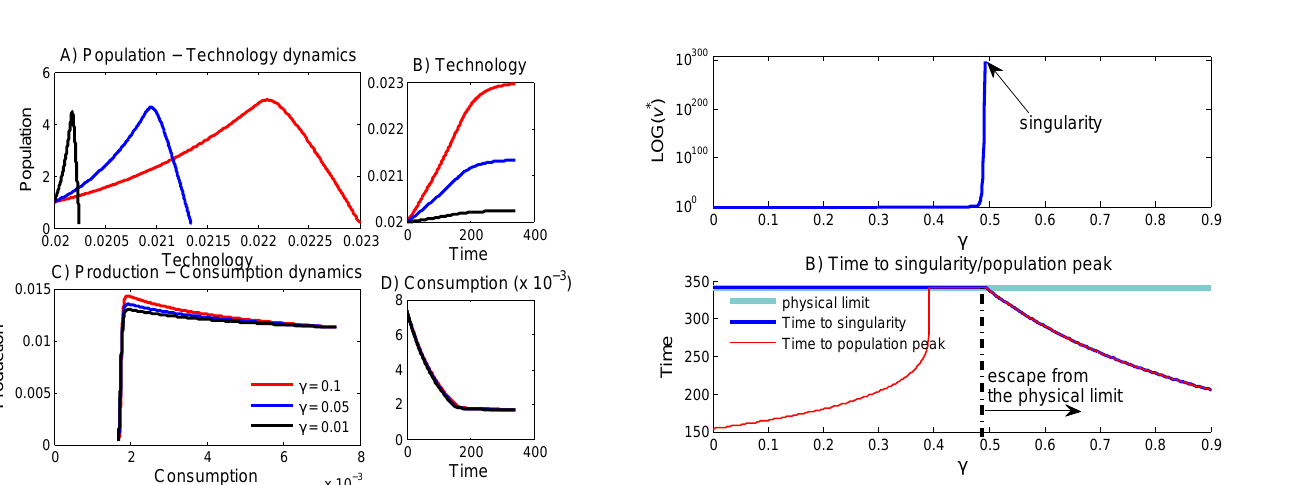
Figure 7. Population–technology and production–consumption dy- namics: the relationship itself evolves over time and varies for dif- ferent rate of success, γ = { 0 . 1 , 0 . 05 , 0 . 01 } considered. Note that consumption per capita declines even when aggregate production rises before its eventual decline. The population growth rate thresh- old is η = 0.25. No randomness in the technological rate of success is assumed, i.e., γ = γ .